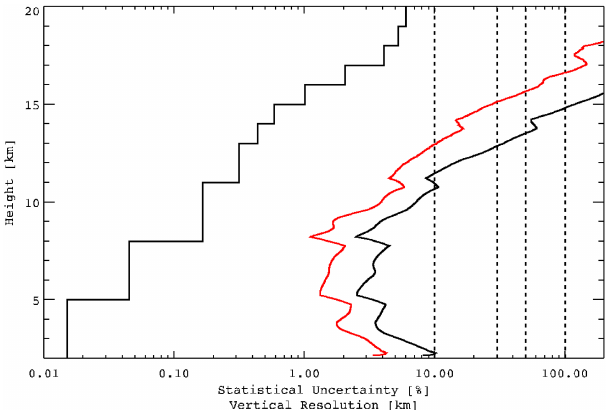
Figure 3. Mean statistical uncertainty (%) after the vertical filtering scheme calculated for 10 nighttime measurements with the same li- dar configuration. Data are temporally integrated for 30 and 120min (black and red curves, respectively). The step black curve represents the corresponding vertical resolution